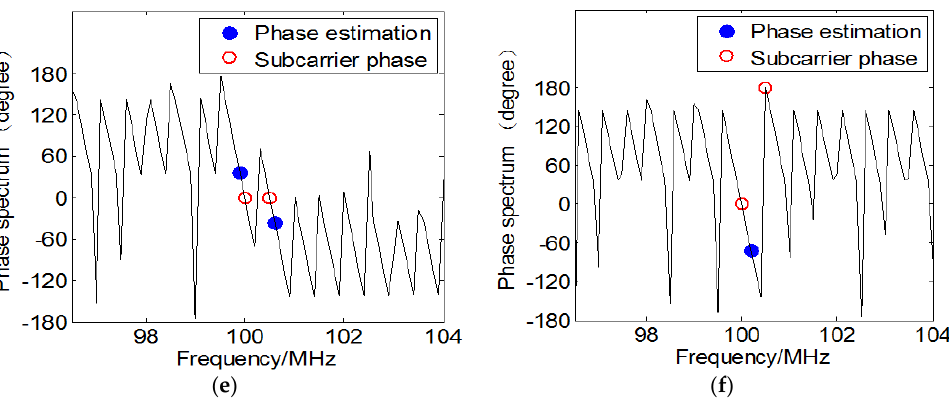
Figure 3. The effect of the subcarriers’ frequencies and phases on spectrum by performing FFT algorithm: ( a ) Subcarrier frequency spectrum ( ∆ ϑ = 0 ) ; ( b ) Subcarrier frequency spectrum ( ∆ ϑ = π ) ;